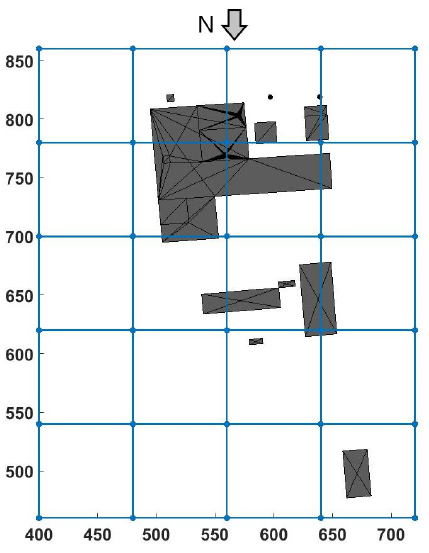
Figure 4. Simulation domain seen from above. Black structure is the representation of the present